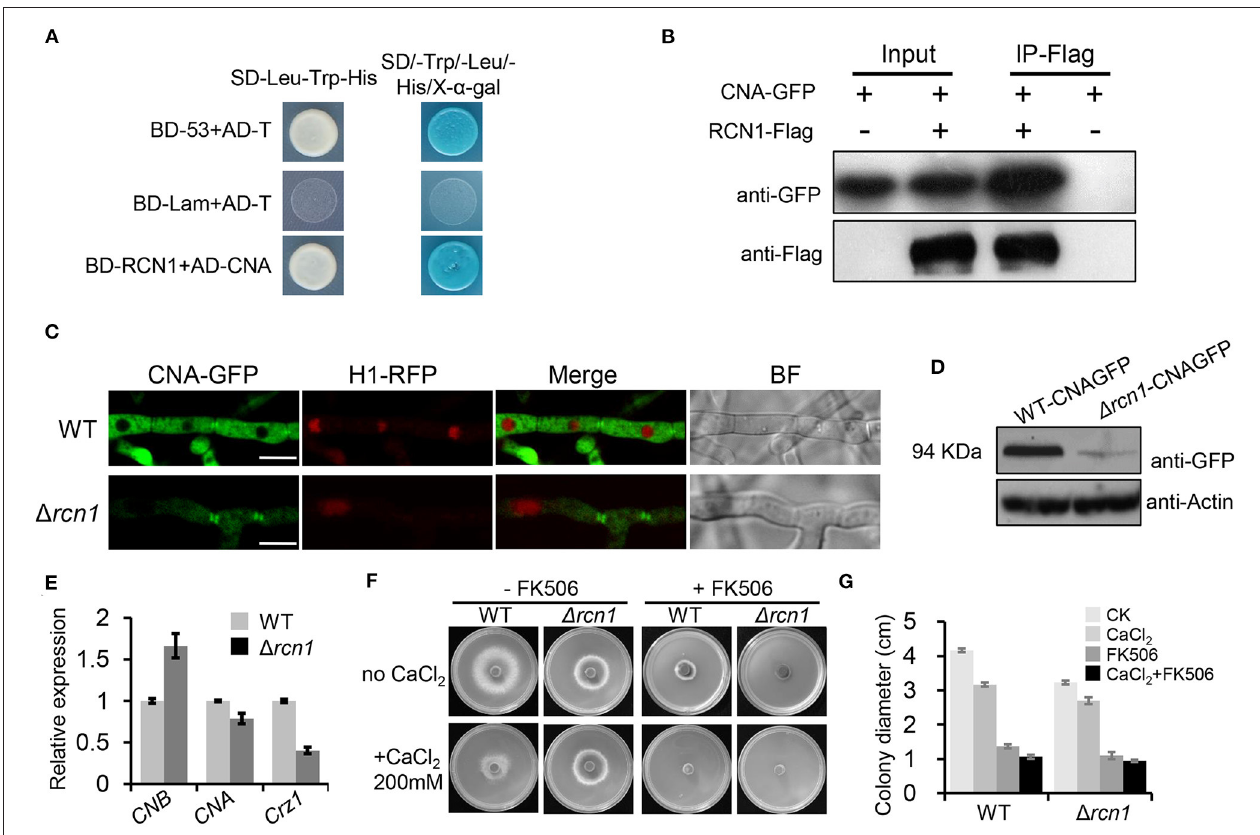
FIGURE 7 | MoRCN1 interacts with MoCNA and affects its protein level. (A) Yeast-two-hybrid assay for the interaction between MoRCN1 and MoCNA. Yeast transformants expressing the prey and bait constructs were assayed for growth on SD-Leu-Trp and SD-Leu-Trp-His-Ade plates stained with X- α -gal. The positive control was the interaction between pGBKT7-53 (BD-53) and pGADT7-T (AD-T), and the negative control was the interaction between pGBKT7-Lam (BD-Lam) and pGADT7-T. (B) Co-immunoprecipitation (CoIP) analyses. The 3 × flag-RCN1 and GFP-MoCNA were co-expressed in the wild-type strain. The Co-IP experiment was performed with the anti-GFP beads, and the isolated protein was analyzed by western blot using anti-FLAG and anti-GFP antibodies. (C) Subcellular localization of MoCNA in WT and 1 Morcn1 mutants. MoCNA and H1-RFP were co-transformed into WT and 1 Morcn1 mutants. The co-localization was observed under the confocal. The arrows point to the mycelial septum. Bar 10 µ m. (D) The protein content of MoCNA in WT and 1 Morcn1 mutants was detected by western blot. (E) The expression level of MoCNA, MoCNB, and MoCRZ1 in WT or the 1 Morcn1 mutants. MoAct1 was used as an internal control. The expression level of different genes in WT was set as 1. (F) Growth of different strains in the presence of CaCl 2 . WT and 1 Morcn1 mutants were inoculated onto MM plates containing CaCl 2 (200mM) with or without the calcineurin inhibitor FK506 (1ng/ml). The colony was photographed at 120h. (G) The colony diameters of WT and 1 Morcn1 mutants in (F)